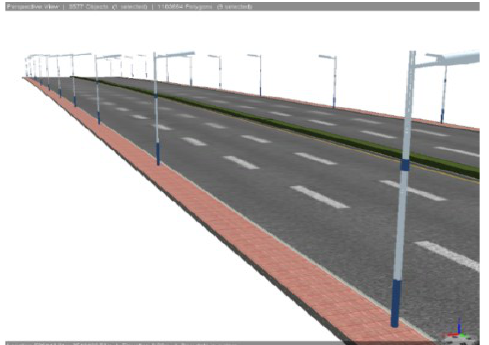
Figure 7. 3D streetlamp model of Dongfeng road